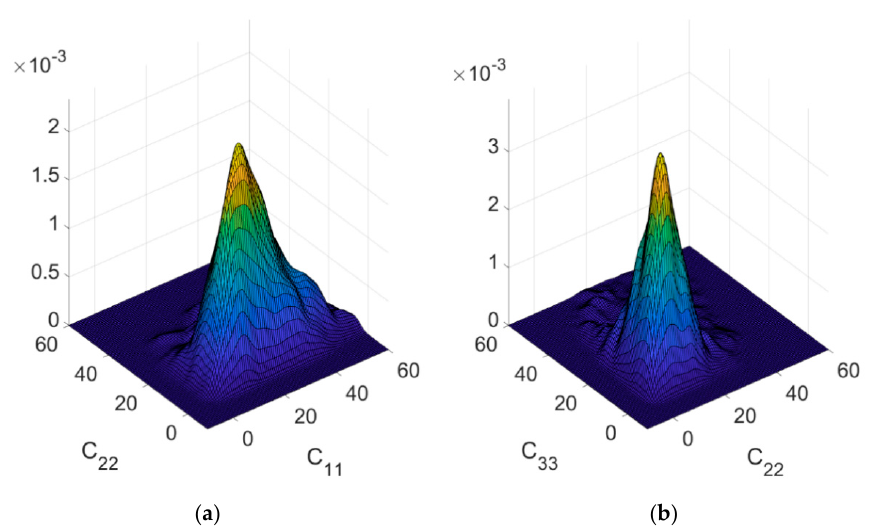
Figure 12. (a) Joint probability density function of random variables 𝐶 (cid:2869)(cid:2869) and 𝐶 (cid:2870)(cid:2870) . (b) Joint probability Figure 12. ( a ) Joint probability density function of random variables C 11 and C 22 . ( b ) Joint probability density function of random variables 𝐶 (cid:2870)(cid:2870) and 𝐶 (cid:2871)(cid:2871) . density function of random variables C 22 and C 33